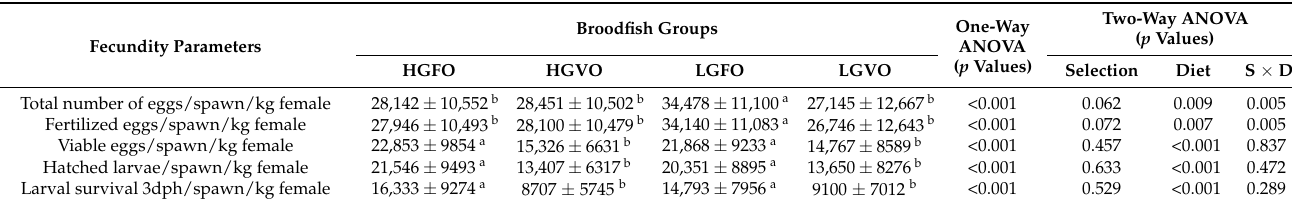
Table 11. Reproductive performance (fecundity) of gilthead seabream broodstock selected for high (HG) or low (LG) growth fed with either FO or VO diet over three months of reproductive season (HGFO, n = 70; HGVO, n = 67; LGFO, n = 72; LGVO, n = 72).